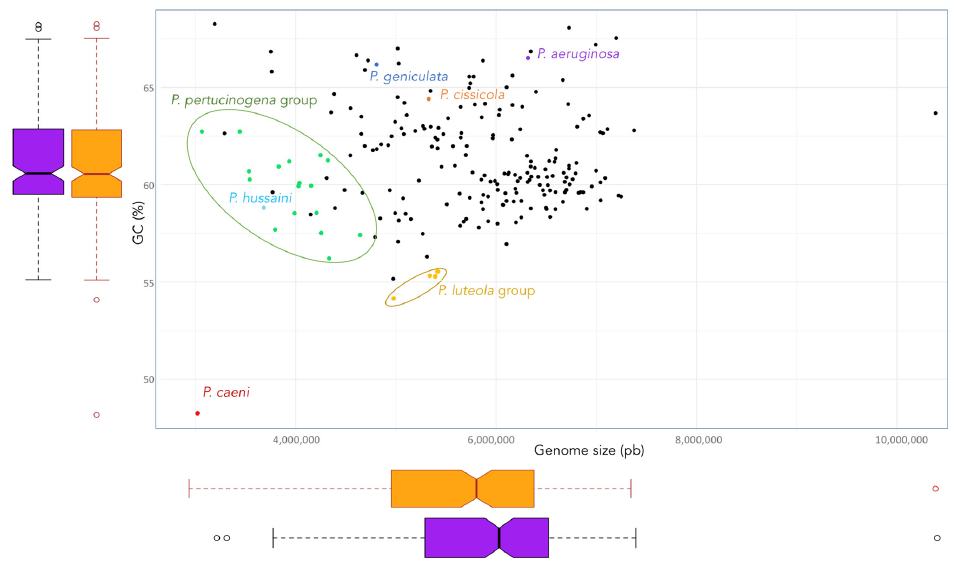
Figure 2. Size and G + C (mol%) content of the genomes of the Pseudomoans type strains. Boxplots represents these genomic features of the genus (orange) and those that remain when exclude the genomes of the type strains of P. hussaini , P. caeni , P. geniculata , P. cissicola , and those of the P. luteola and P. pertucinogena clades (purple). Biology 2021 , 10 , 782